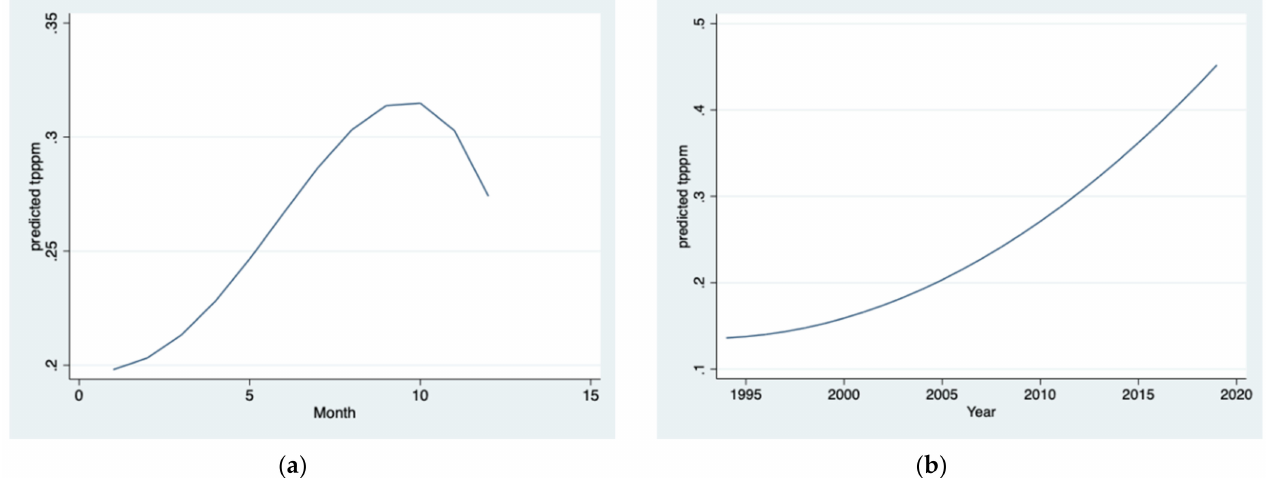
Figure 13. Fractional polynomial regression between monthly ( a ) and annual ( b ) means (1994–2018) of TPout concentrations (ppm).